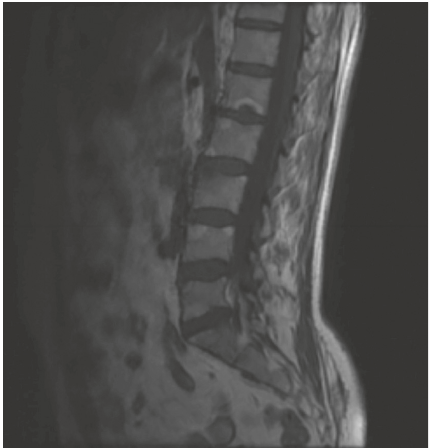
Figure 2: T1-weighted sagittal MRI scan of the lumbar spine indicating old Romanus